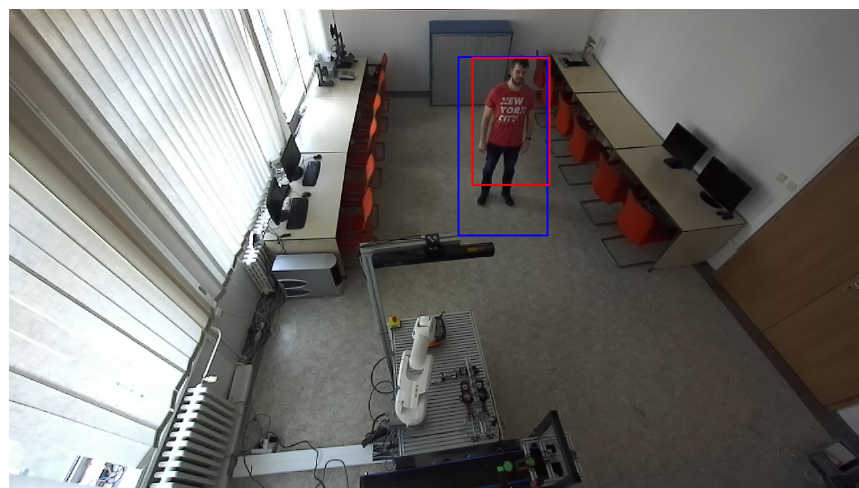
Figure 11. Verification of human presence. The red rectangle represents an identified object based on depth change. The blue rectangle represents an identified potential person based on the HOG